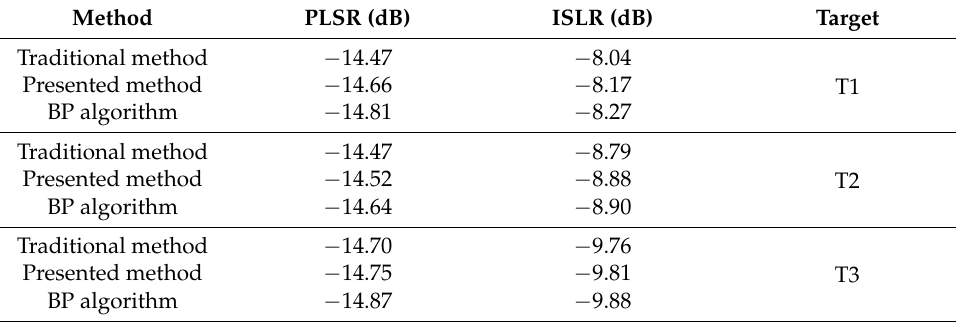
Table 5. Comparison of imaging quality with a narrow-bandwidth case.